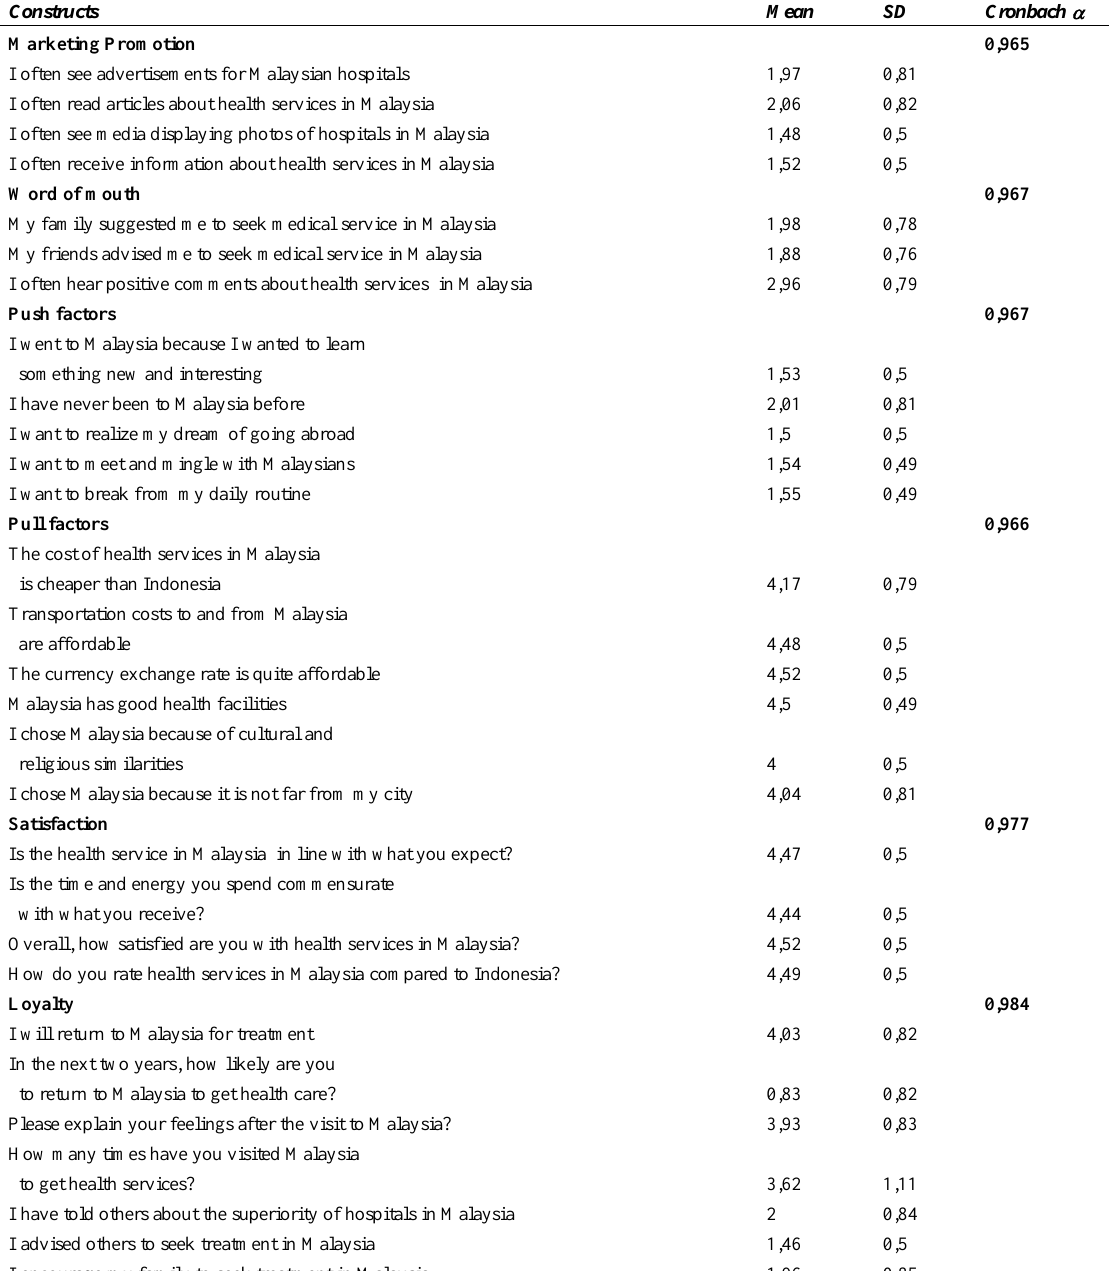
Table 1: Variable